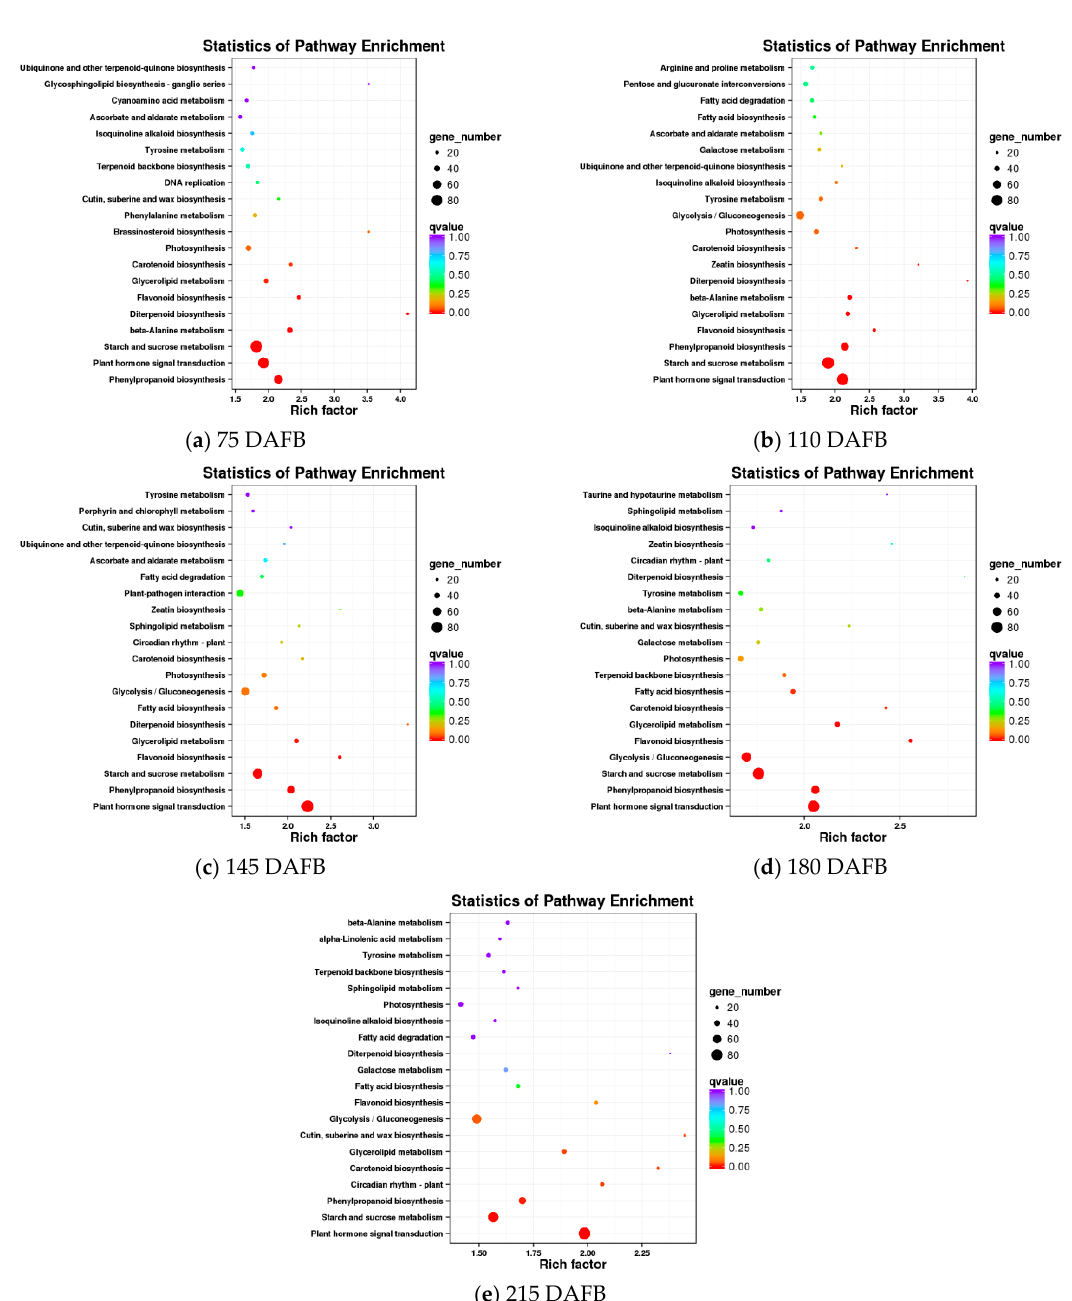
Figure 3. Results of the KEGG enrichment analysis of differentially expressed genes (DEGs) between the avocado mesocarp and seed at five developmental stages. Table 1. Unigenes related to carotenoid biosynthesis.